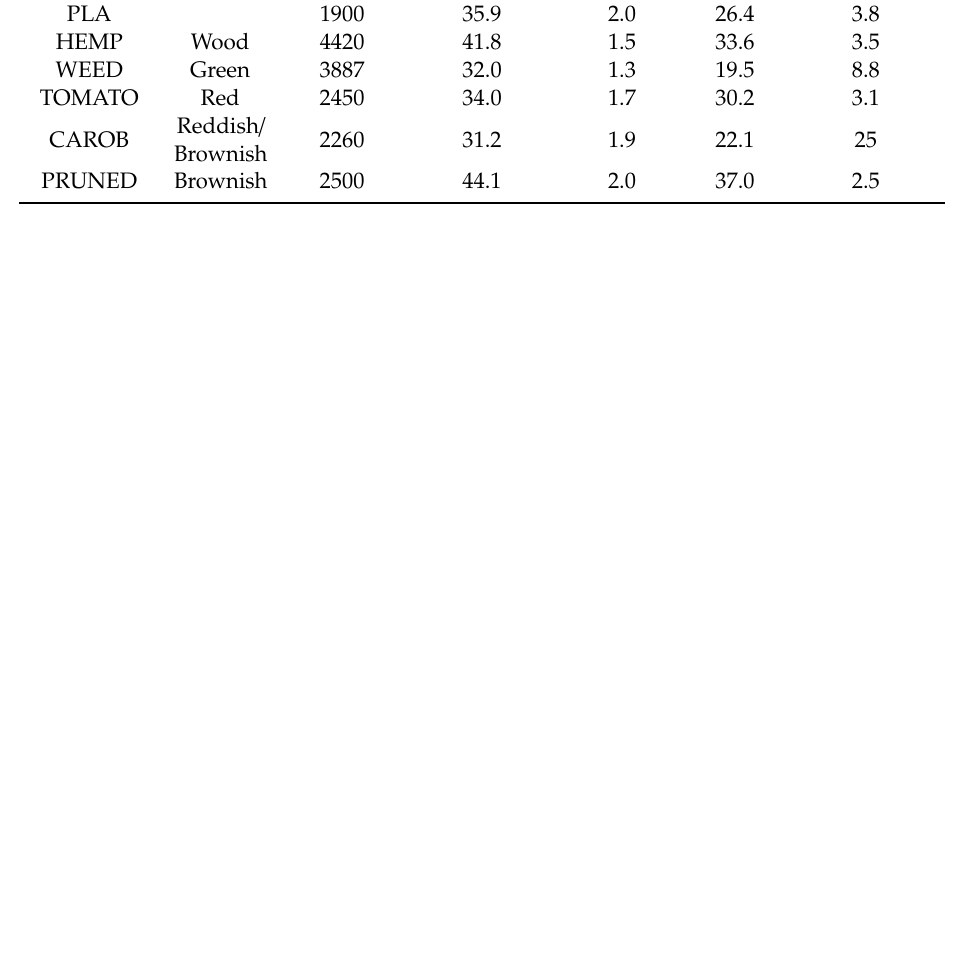
Figure 5. Elastic modulus (up) and Yield stress (down) for PLA and filled materials.